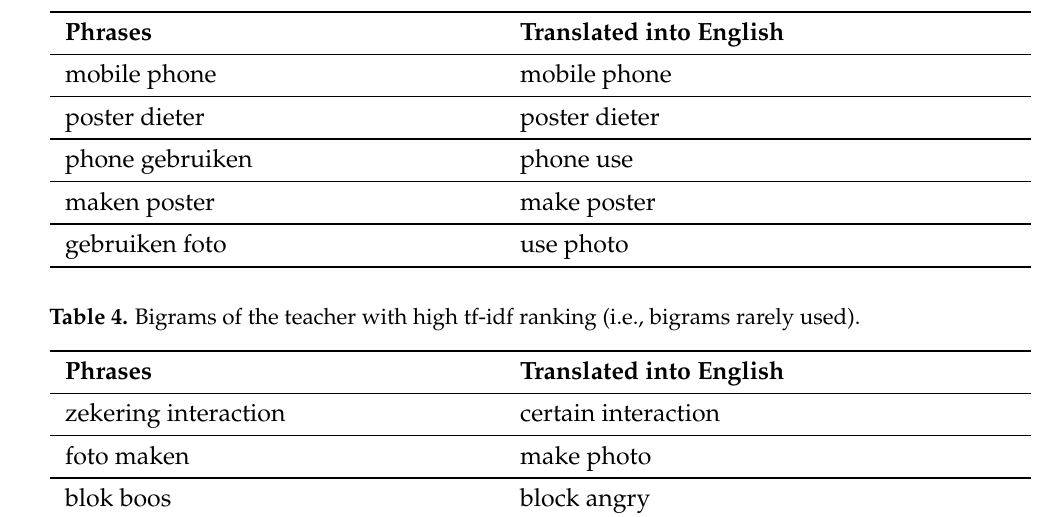
Table 3. Bigrams of the TEL LA advisor with low tf-idf ranking (i.e., bigrams frequently used).